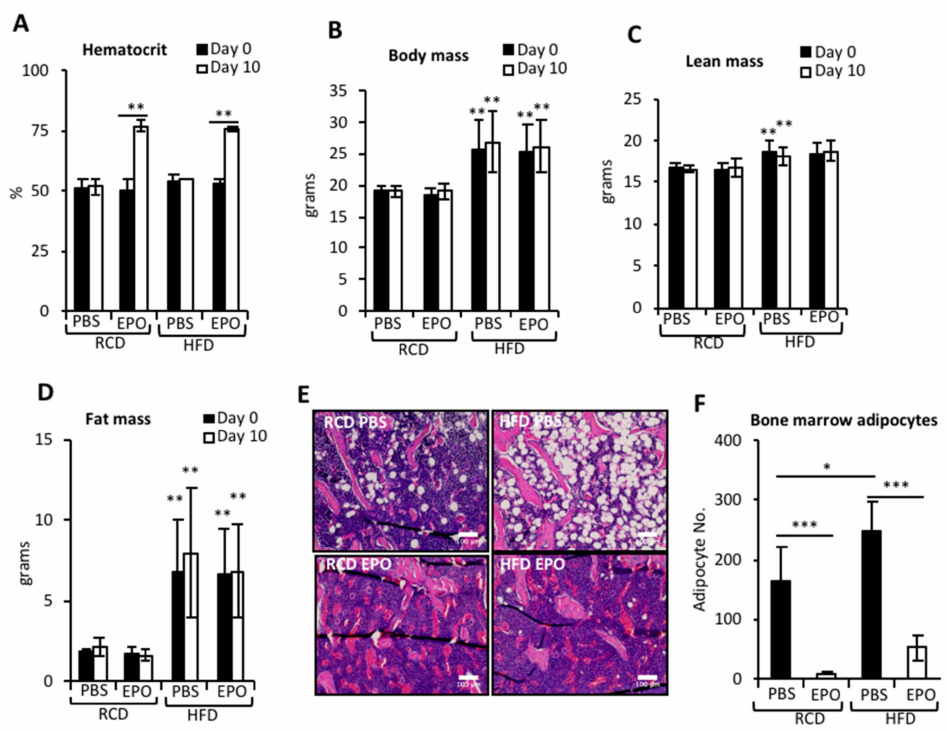
Figure 1. Erythropoietin (EPO) administration in high-fat diet (HFD)-fed mice decreases bone marrow adipocytes (BMAT) expansion. ( A ) The hematocrit measurements on day 0 (black bars) and day 10 (white bars) in female C57BL6 / J mice fed either regular chow diet (RCD) or four weeks of high-fat diet (HFD) containing 60 kcal% fat (high-fat, 5240kcal / kg, 34.9% crude fat). Blood was collected from tail